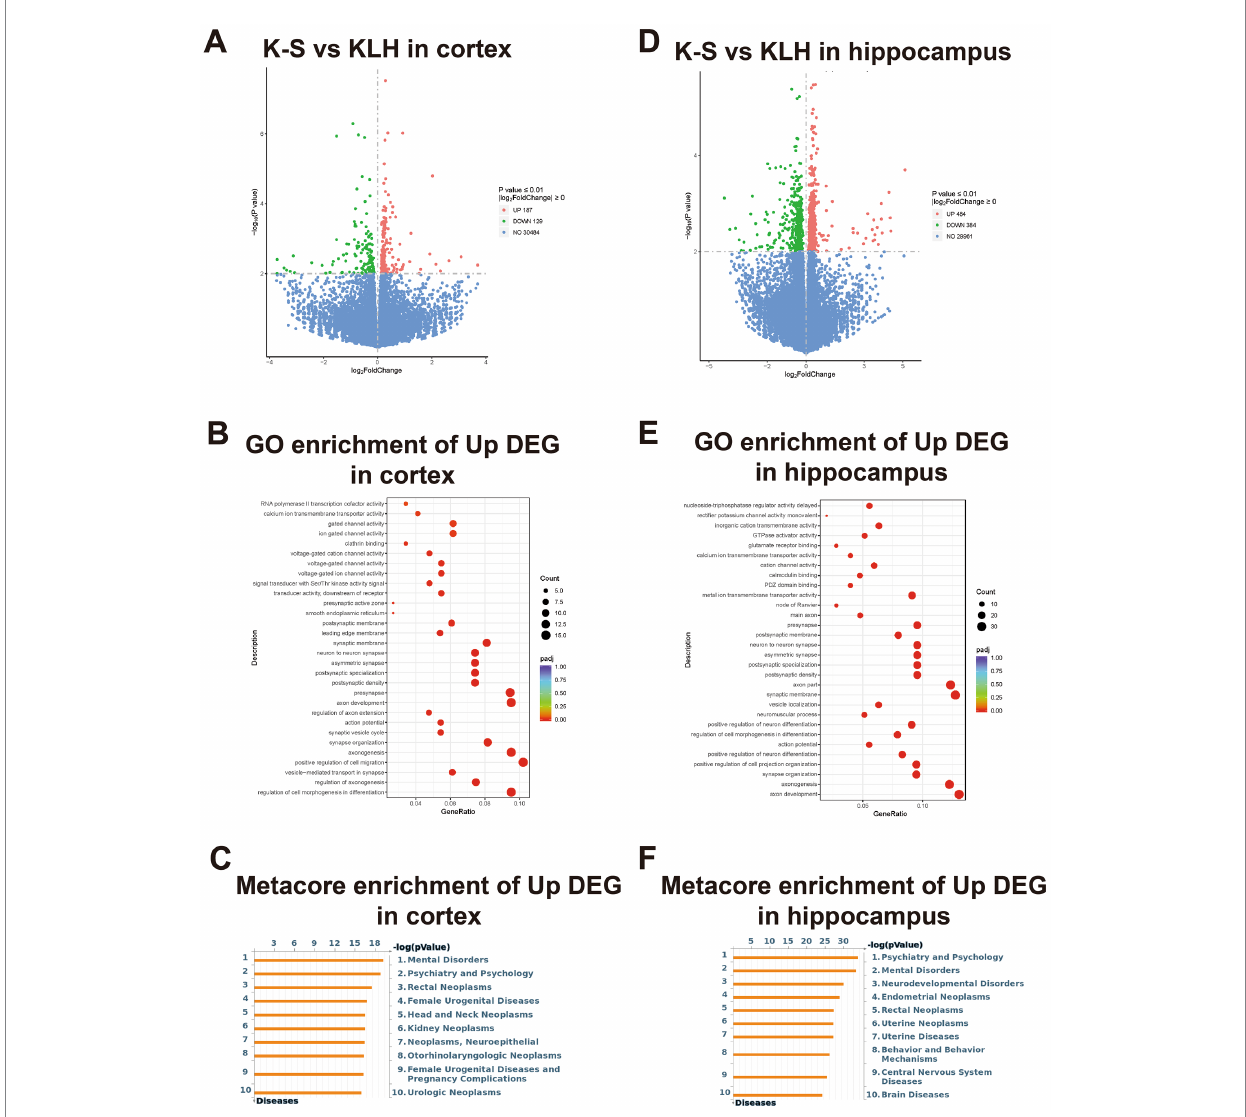
FIGURE 5 The enriched functional analysis and transcriptional profiles of DEmRNAs. (A,D) Volcano plot pictures show log 2 FC values and -log10 ( p value) of mRNAs in immunized mice. (B,E) Bubble plot showing the GO enrichment of up-regulated genes. (C,F) Bubble plot showing the Metacore enrichment of up-regulated